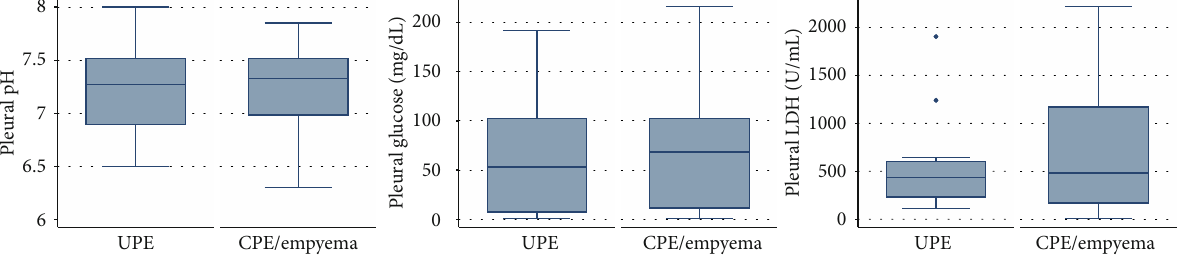
Figure 2: Pleural pH, pleural glucose, and pleural LDH in cytologic diagnosis of UPE and CPE/empyema.